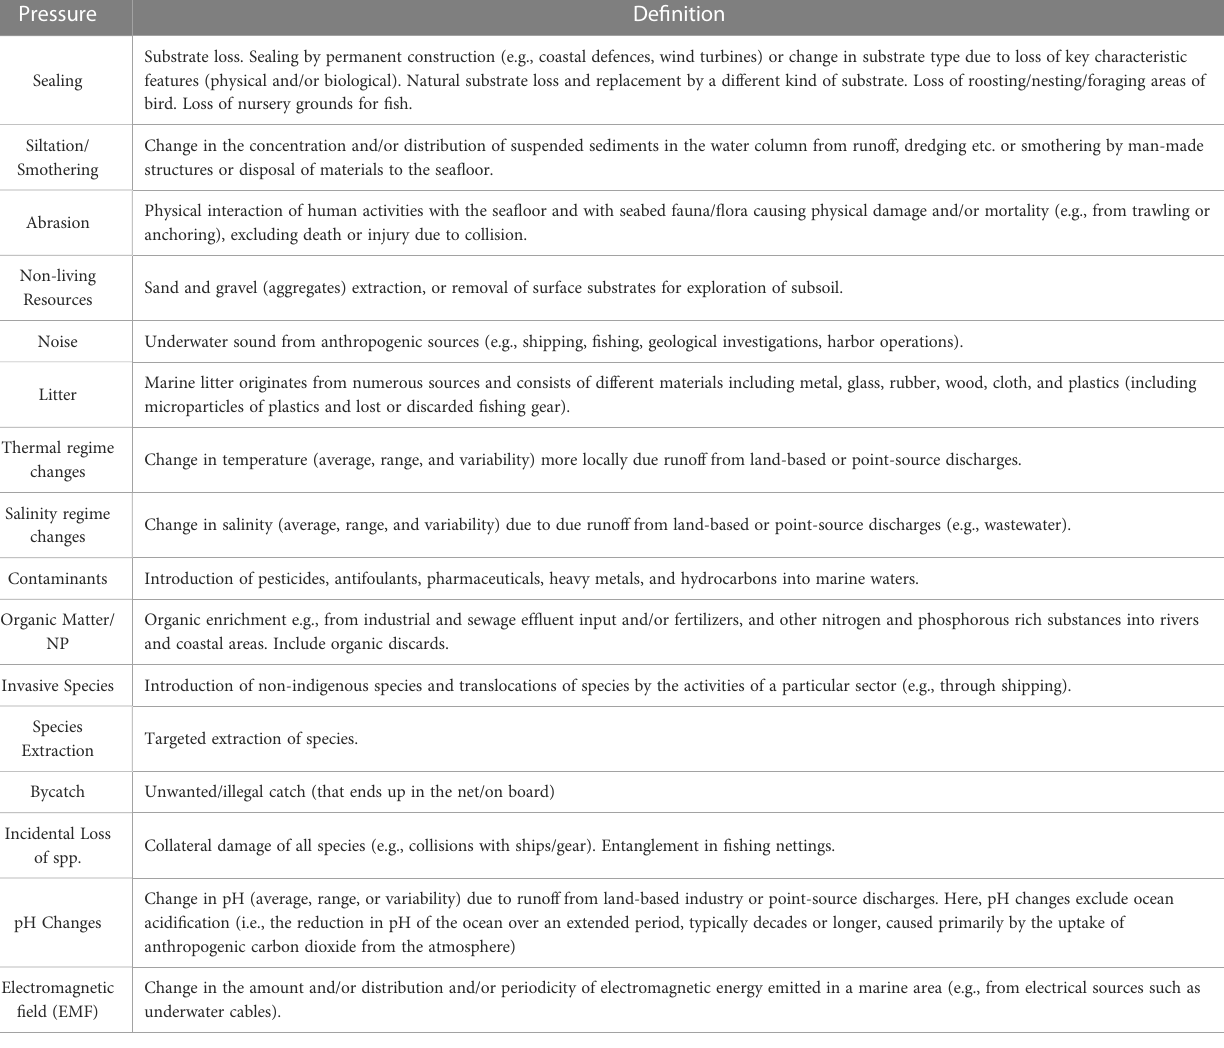
TABLE 2 Individual Pressures de fi nition. Pressure De fi nition